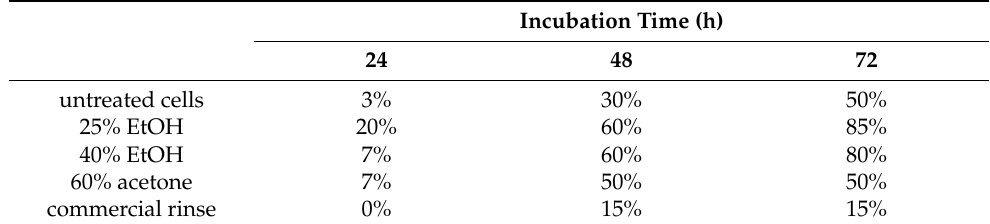
Table 1. Wound (gap) closure percentage. Data obtained in ImageJ.